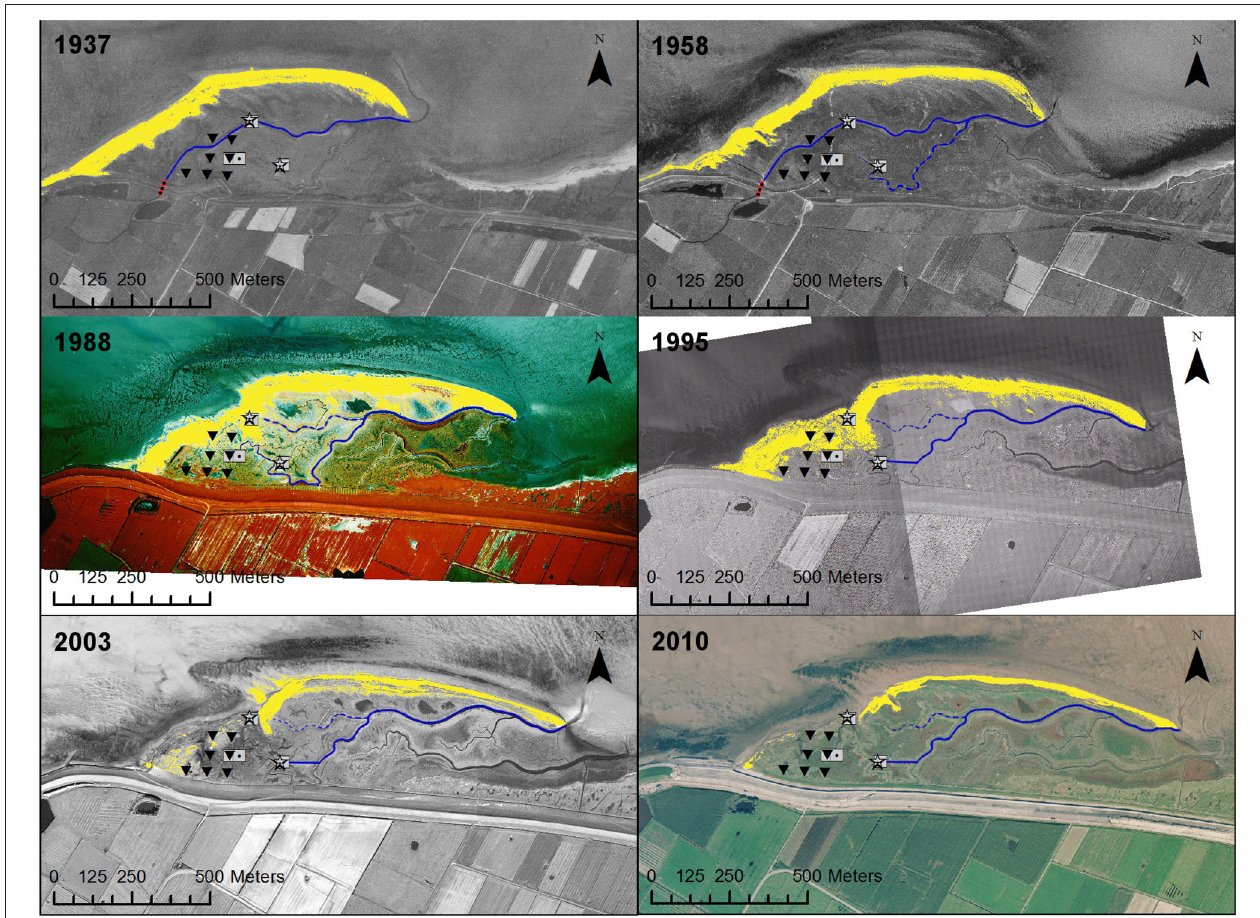
FIGURE 3 | Aerial photographs showing changes in the Oldsumer foreland and outer sand spit (in yellow) from 1937 to 2010. Triangles indicate the sampling locations as described in Figure 2 . The squares and stars indicate the locations of the pressure sensors and the SSC measurements, respectively, as displayed in Figure 2 . In 1937 and 1958 the outlet sluice in the dike is indicated as a red-dashed line, whereas the (dashed) blue lines indicate the observed shift of the northern creek system following the dissection of the original branch of the creek system during the overwash event.